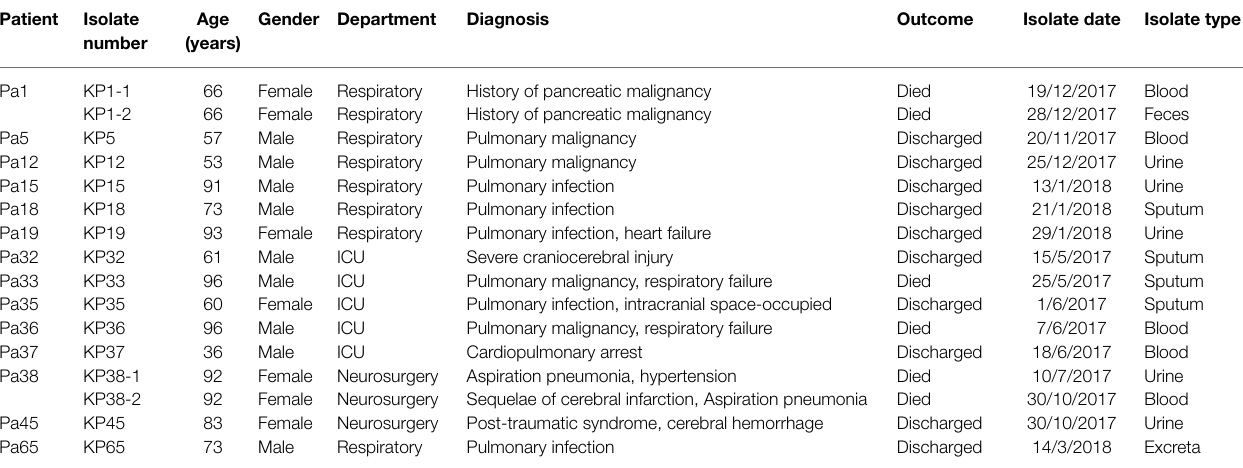
TABLE 1 | Characteristics and outcomes of the 14 inpatients involved in the KPC-2-producing ST11-KL64 CRKP isolates outbreaks. Patient Isolate number